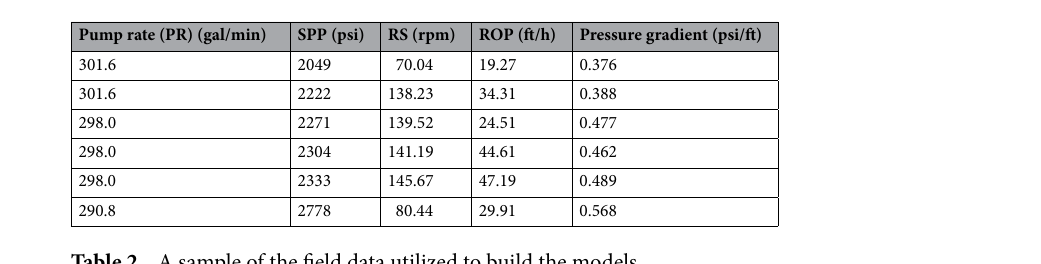
Table 1. Data statistical Analysis.